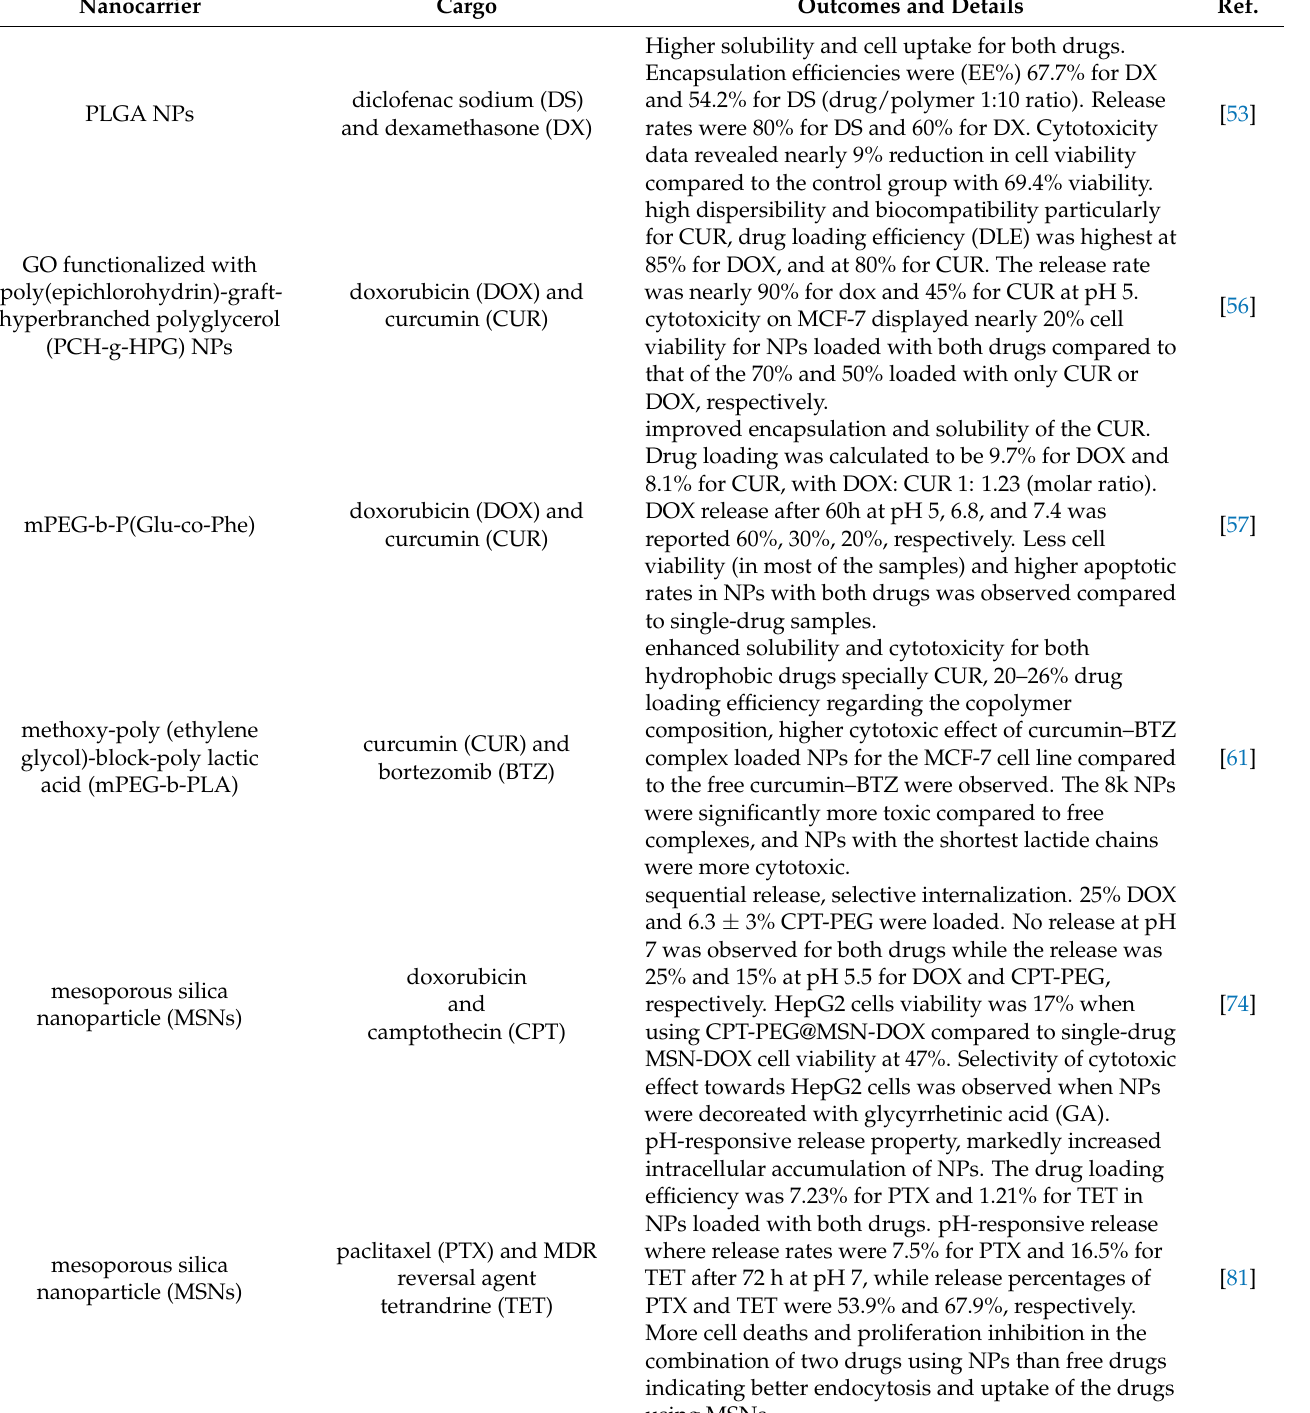
Table 1. An instant overview of the mentioned uniform dual delivery